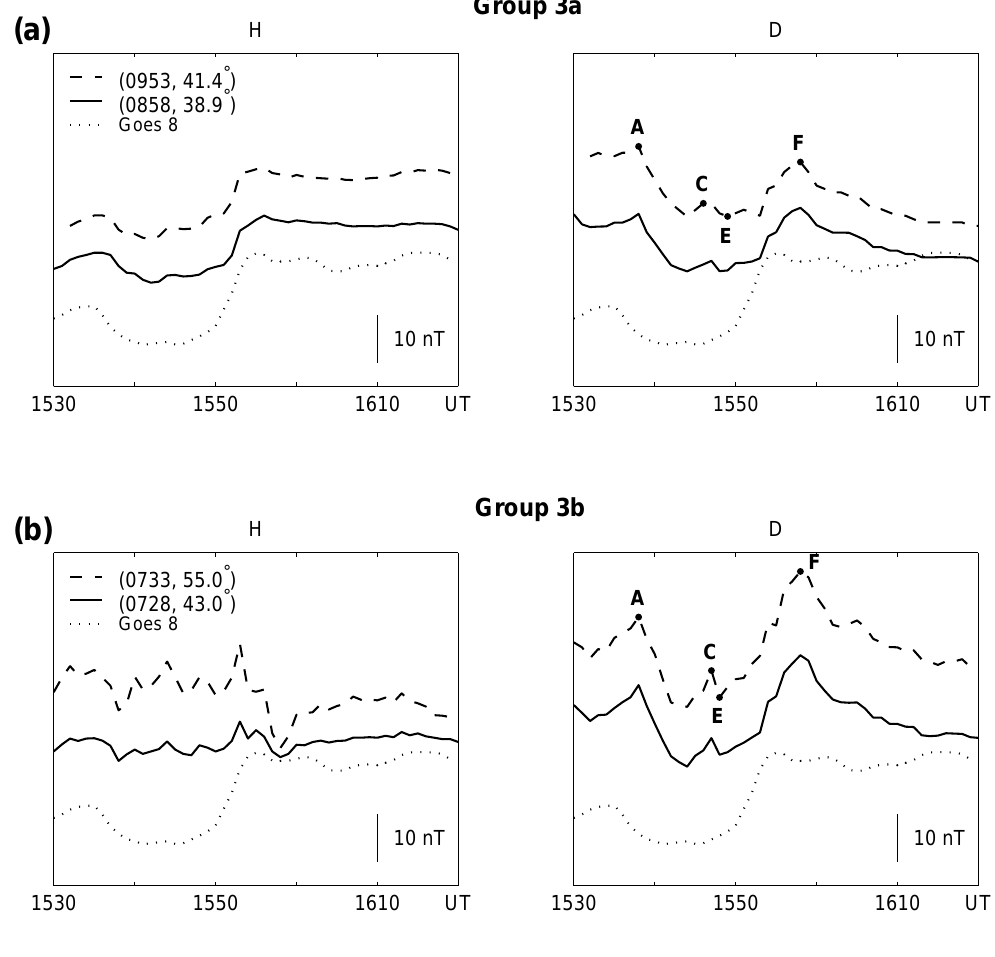
Fig. 4. The same as in Fig. 3b for group 3a ( a ) and 3b ( b )